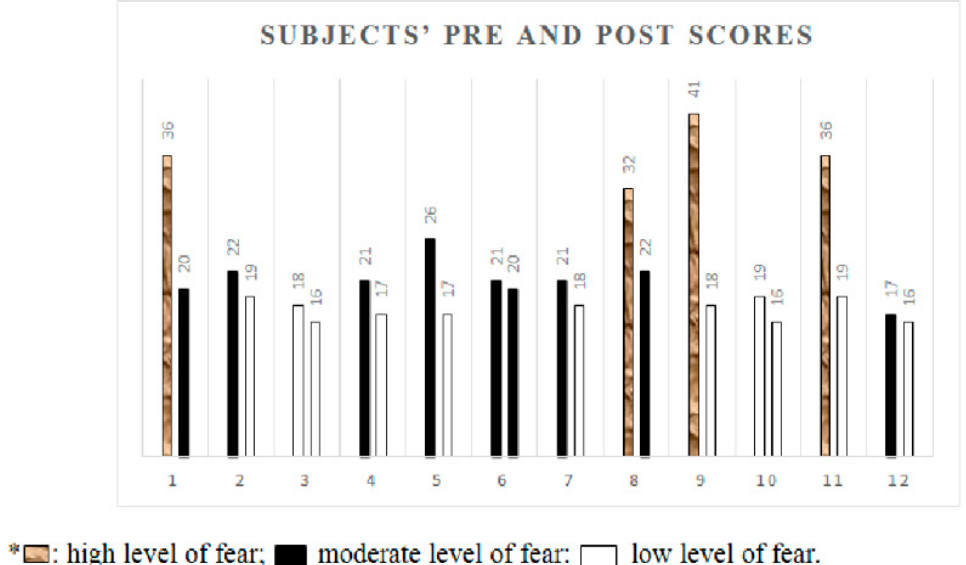
Figure 2. Scores obtained in the FES-I before and after the intervention according to levels of fear of falling.